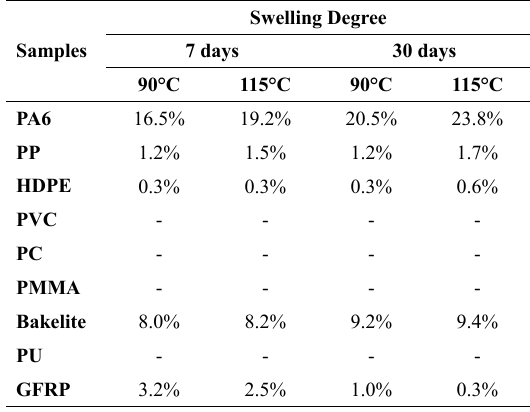
Table 1. Swelling degree of the materials after the chemical resistance testing.